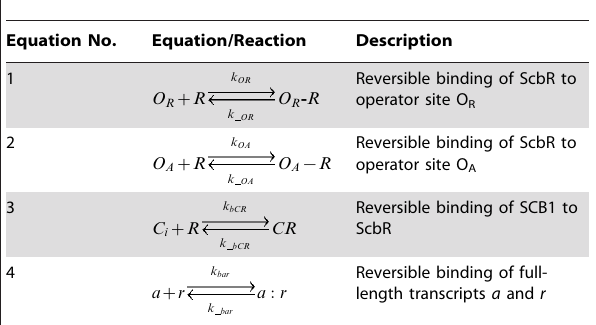
Table 1. Reactions in scbA-scbR gene network.